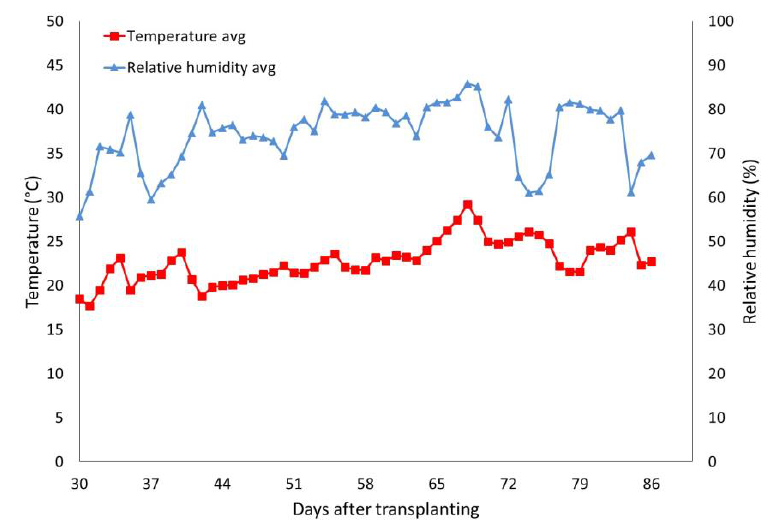
Figure 1. Climatic conditions (average daily temperature and relative humidity) inside the greenhouse during the evaluation period.